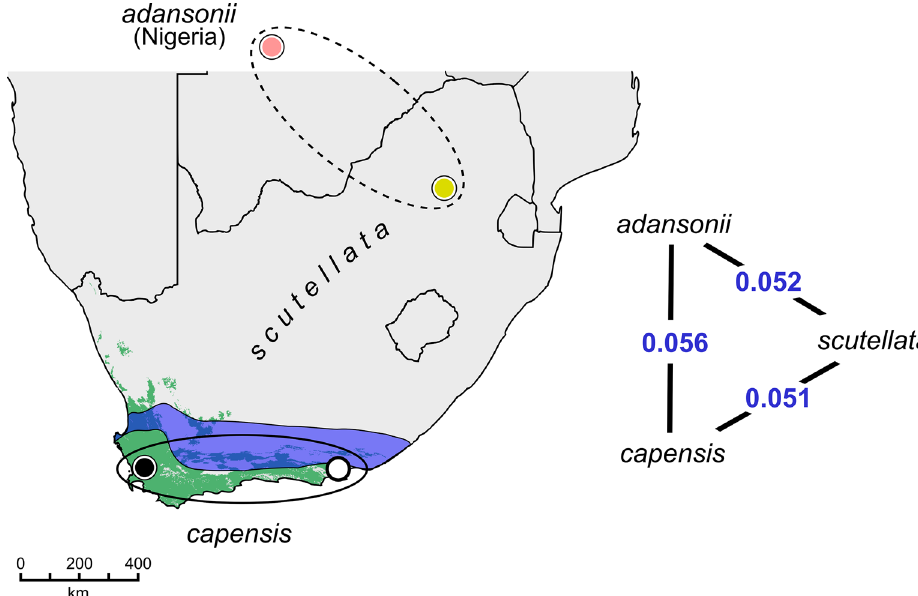
Fig 1. Geographical location of population samples. The thelytokous and parasitic Cape bee Apis mellifera capensis (lower ellipse) inhabits the Fynbos ecoregion (green) of South Africa. It was sampled from the western Fynbos (Stellenbosch, Cape Town; black circle) and eastern Fynbos (near Kragga Kamma Game Park, Port Elizabeth; white circle) and compared to two arrhenotokous and non-parasitic African populations (upper dashed ellipse). A . m . scutellata is widespread throughout of the Central Plateau and was sampled in the Pretoria region (yellow circle). A transitional zone with mixed phenotypes exists between the two subspecies (blue region). A . m . adansonii bees (pink) were sampled in Kaduna state, Nigeria (outside map). The schematic triangle specify the genome-wide levels of divergence between the three populations ( F ST estimator of Reynolds et al .